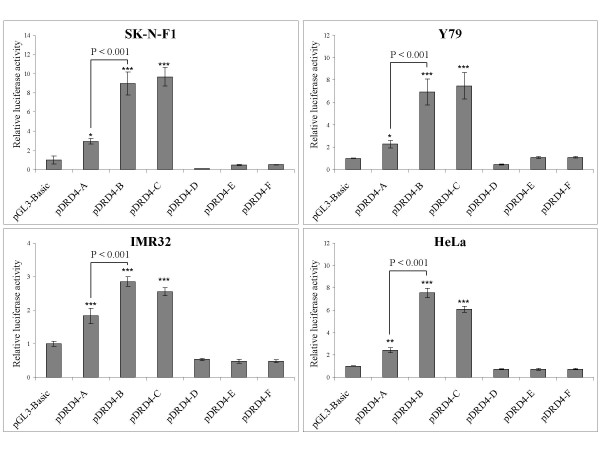
The effect of 5' deletions on the transcriptional activity of the DRD4 promoter in four different cell lines. Significant difference in promoter activity of pDRD4-A could be observed in each cell line relative to construct B (P < 0.001). Luciferase activity was normalized to the β-galactosidase activity. Data are expressed as fold increments over the pGL3-Basic activity and shown as mean ± SD. Results of a representative experiment are shown as measured in triplicates (*P < 0.05, **P < 0.01, ***P < 0.001 versus the corresponding promoterless vector in each cell type.) Similar data were obtained from three independent transfection experiments.